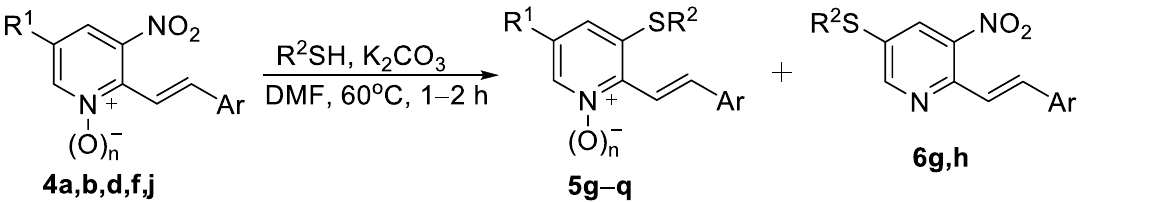
Table 2. Reactions of 2-(arylvinyl)-3-nitropyridines with thiols.